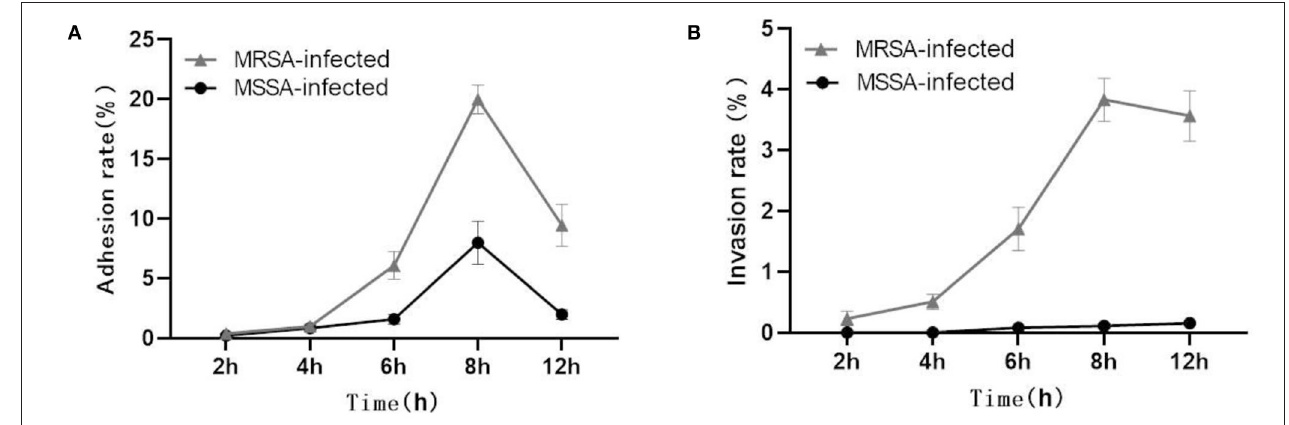
FIGURE 1 | Adhesion and invasion rates in MRSA-infected group and MSSA-infected group. (A) The adhesion rate of MRSA-infected and MSSA-infected MAC-T cells. (B) The invasion rate of MRSA-infected and MSSA-infected MAC-T